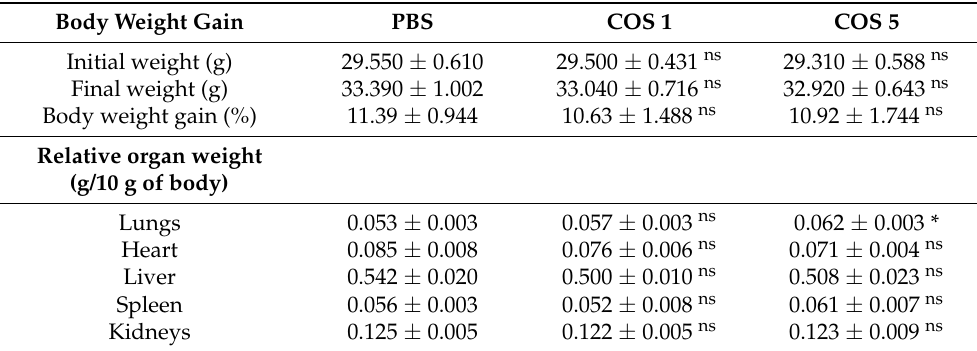
Table 1. Body weight gain and relative organ weight of mice treated by intragastric route with COS1 and COS5 in the acute toxicity